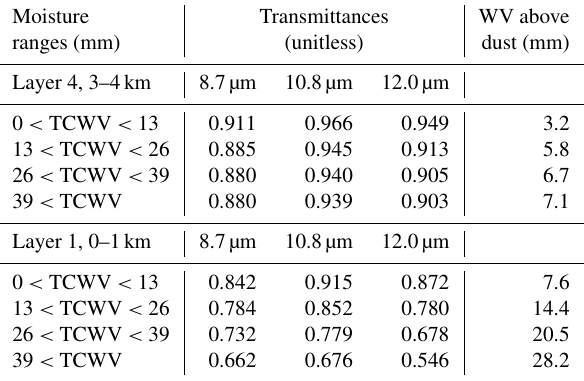
Table 4. As with Table 3, COSMO-MUSCAT-RTTOV-simulated mean atmosphere-only channel transmittances above the specified dust layers. These are averaged within the specified total column water vapour ranges (defined in Table 2 as “dry”, “dry-moist”, “moist”, and “wet”), for points within the thick dust AOD range (from 2 to 3), for consistency with the outer rings of Fig. 7. Also included are the mean water vapour column values above the spec- ified dust layers.